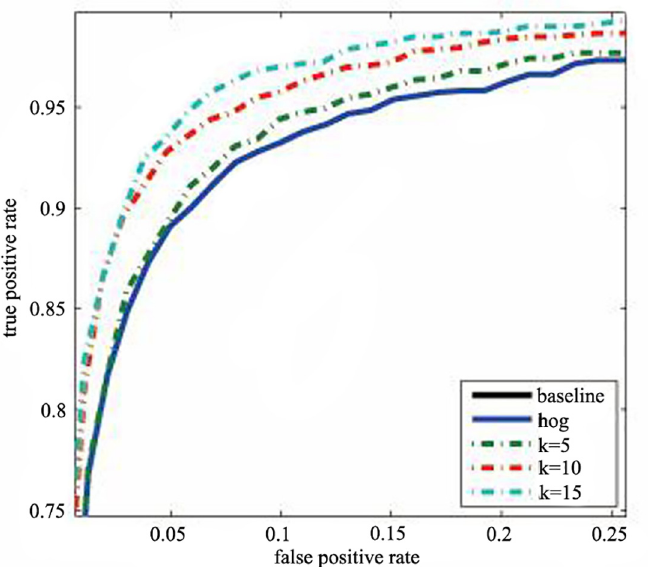
Fig 1. The performance of selected k .